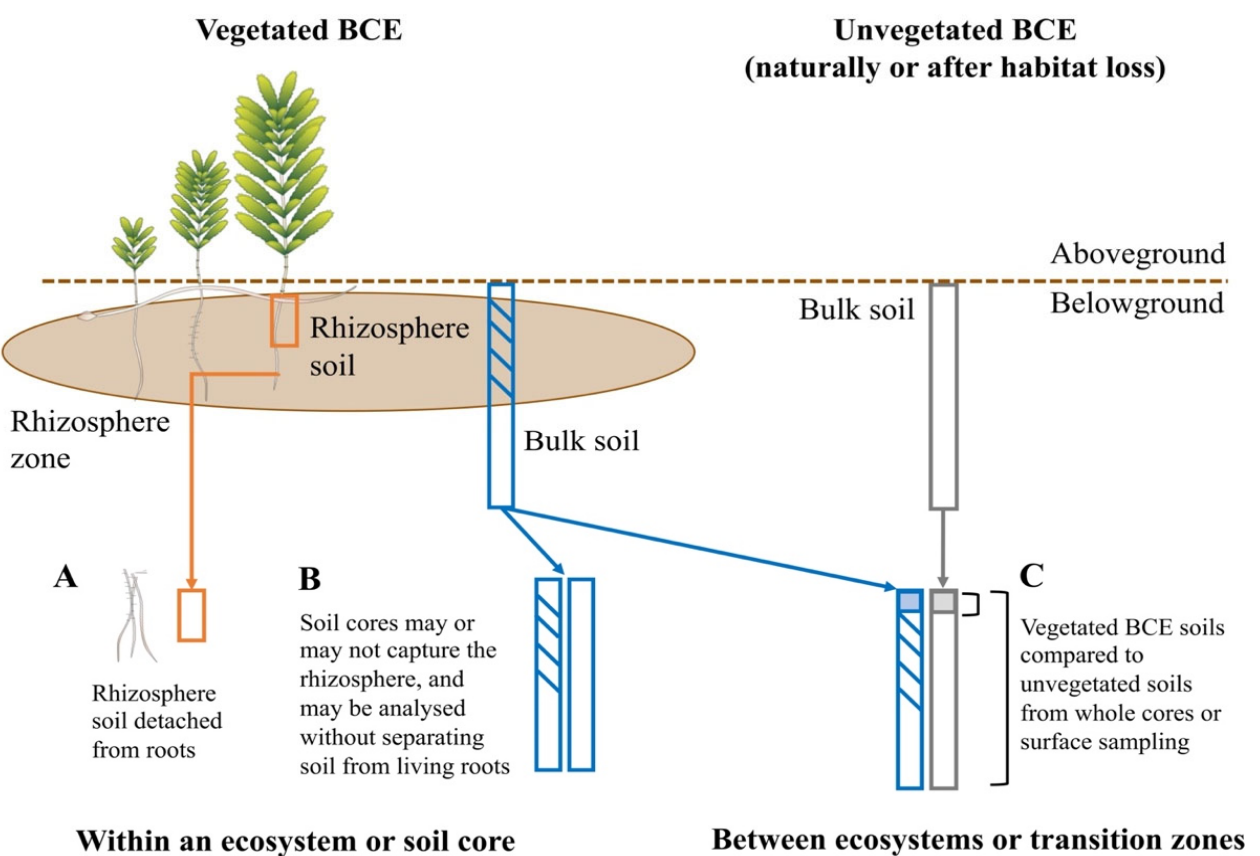
Figure 1. Studying Blue Carbon belowground microbiomes within different compartments based on sampling approaches. Belowground microbial communities associated with Blue Carbon Ecosystems (BCEs) can be studied within a soil core or relatively small scales, e.g., plots (left), or across larger areas, e.g., within or among ecosystems or transition zones (right). Microbial heterogeneity in BCEs is assessed through the comparison of belowground fractions, including the roots and the rhizosphere ( A ), as well as bulk soils ( B ), under the hypothesis that plant-associated interactions play a major role in shaping the microbiome. Vegetated areas (covered by seagrass, mangroves, or saltmarshes) are sampled by coring for microbiome or carbon and may capture partially the rhizosphere ( B ), and are sometimes compared to adjacent, naturally unvegetated areas, such as mud flats and large bare patches, or ecosystems that have experienced habitat loss. Microbiomes within unvegetated BCEs are often compared by sampling bulk soil through scooping (surficial soil) or coring (soil core) ( C ), under the hypothesis that differences in biogeochemistry, redox potential, and food sources for the microbes likely result in different microbial community structure and function, including roles related to carbon and nitrogen cycling. Diagram created using the IAN image library